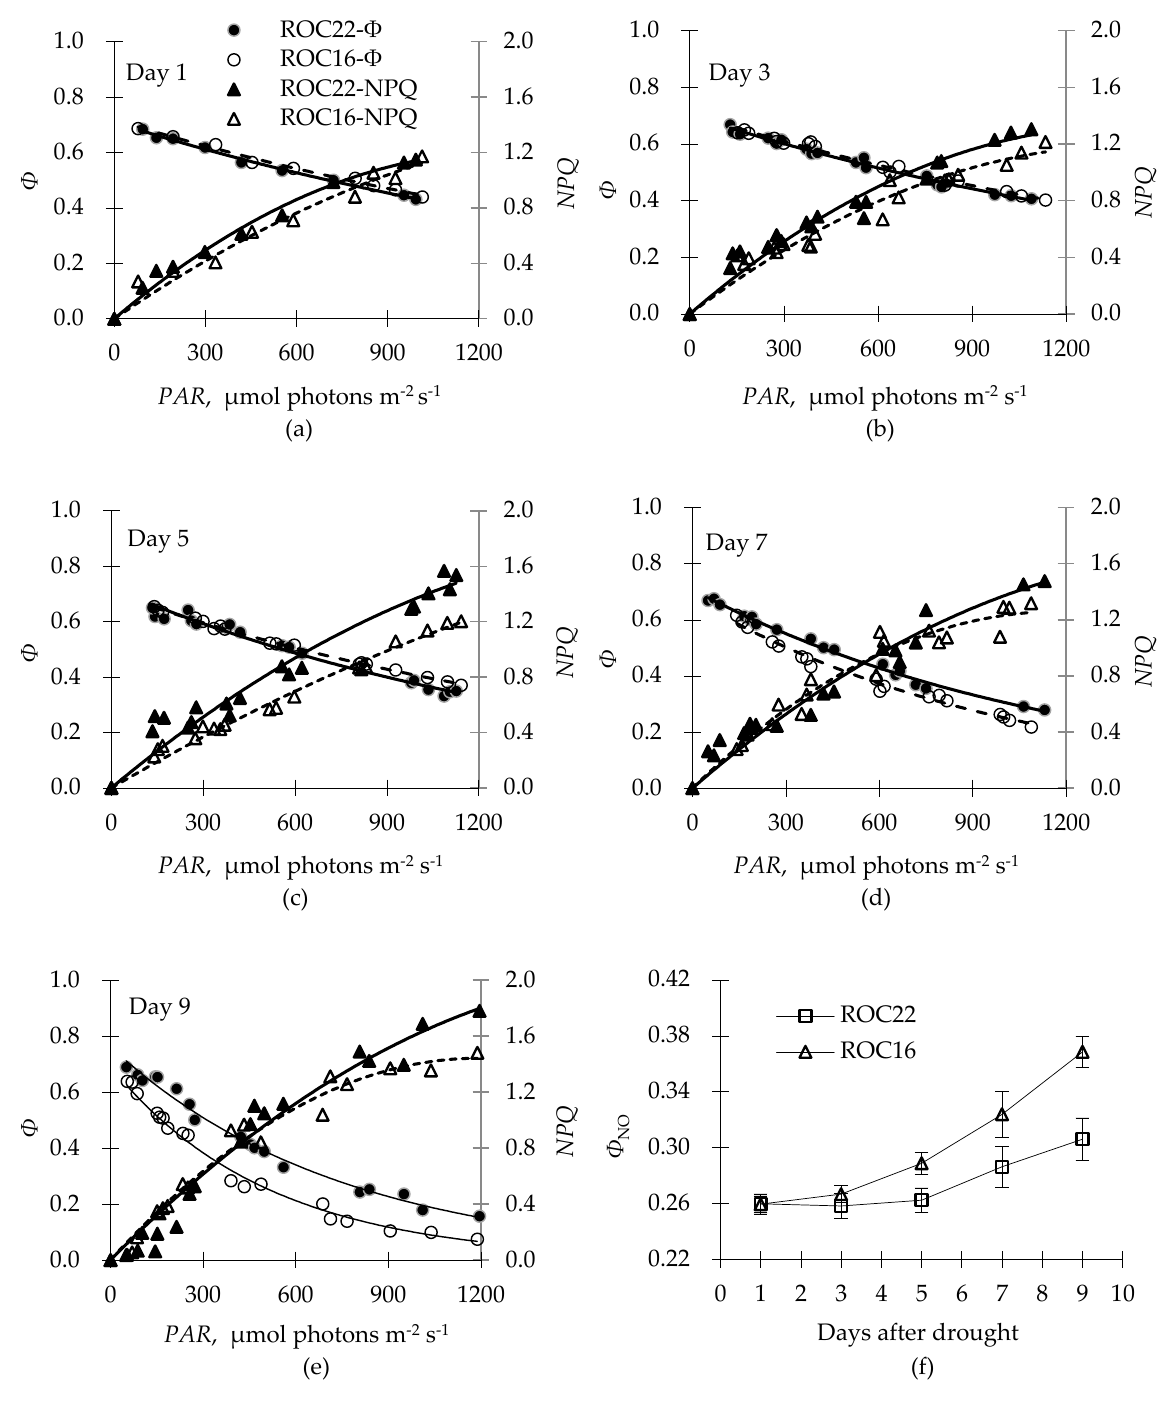
Figure 3. Excitation light-energy distribution in the two tested cultivars at 1, 3, 5, 7, and 9 days after drought treatment. ( a – e ) The photosynthetic quantum efficiency ( Φ ) and nonphotochemical quenching ( NPQ ) varied with PAR for two tested cultivars after withholding water (( b – e ) share the same legend as ( a )). ( f ) Average value of the yield for other energy losses ( Φ NO ) under different PAR vaired with the aggravation of drought stress for two tested cultivars.